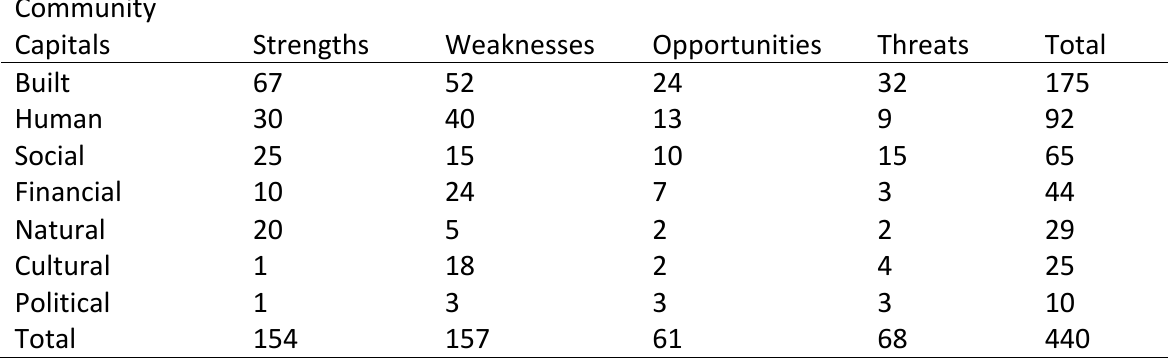
Frequency of Strengths, Weaknesses, Opportunities, and Threats by Community Capitals